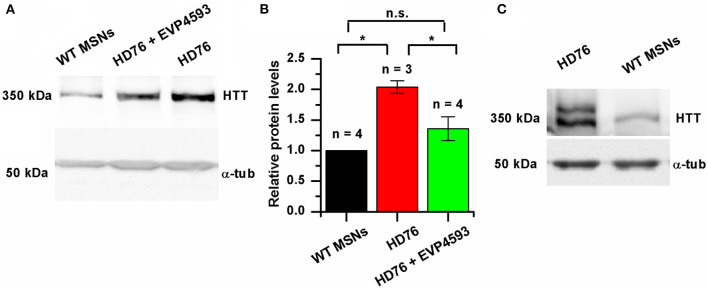
EVP4593 reduces the excessively increased level of mutant huntingtin. (A) Representative Western blot showing the expression level of total HTT in HD76, HD76 incubated with 300 nM EVP4593 for 24 h and WT GABA MSNs. Band intensities were quantified and values normalized to the α-tubulin housekeeping protein. (B) Relative HTT levels in WT (black), HD76 (red) and HD76 incubated with 300 nM EVP4593 for 24 h (green). Biological replicates are indicated above the bars. (C) Representative Western blot showing the expression level of normal and mutant HTT in HD76 and WT GABA MSNs. The asterisk indicates that differences in protein levels are statistically significant (p < 0.05).